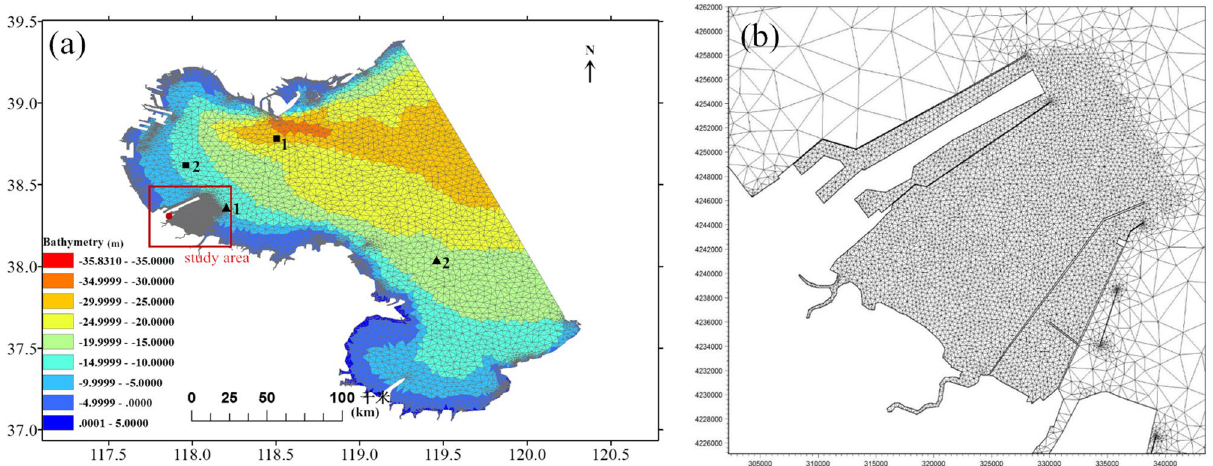
Figure 4. ( a ) Large scale unstructured mesh built on the bathymetry of inner Bohai Gulf, with locations of 2 wave buoys (black triangle), 2 current gauges (black square), and 1 tide station (red circle); ( b ) densified grids in the study area (processed by Mike 21 at https ://www.mikep owere dbydh i.com/produ cts/mike-21).